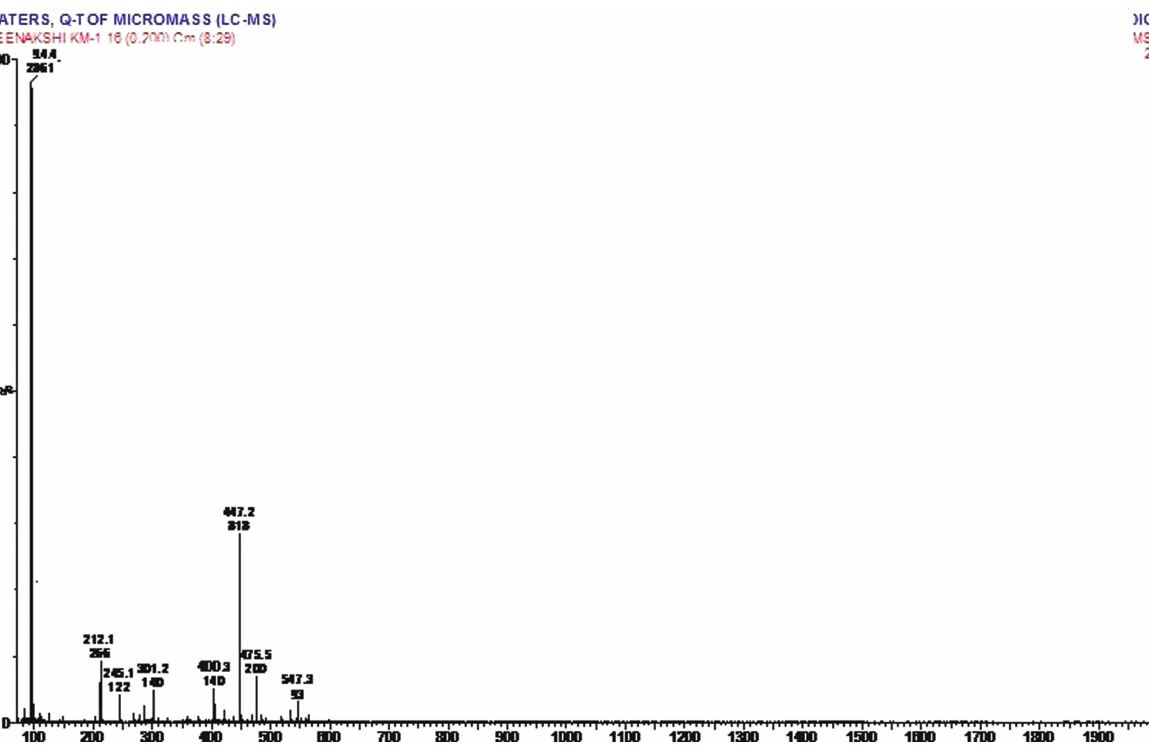
Figure 3: Q-TOF(LC-MS) spectrum of complex [(spca)